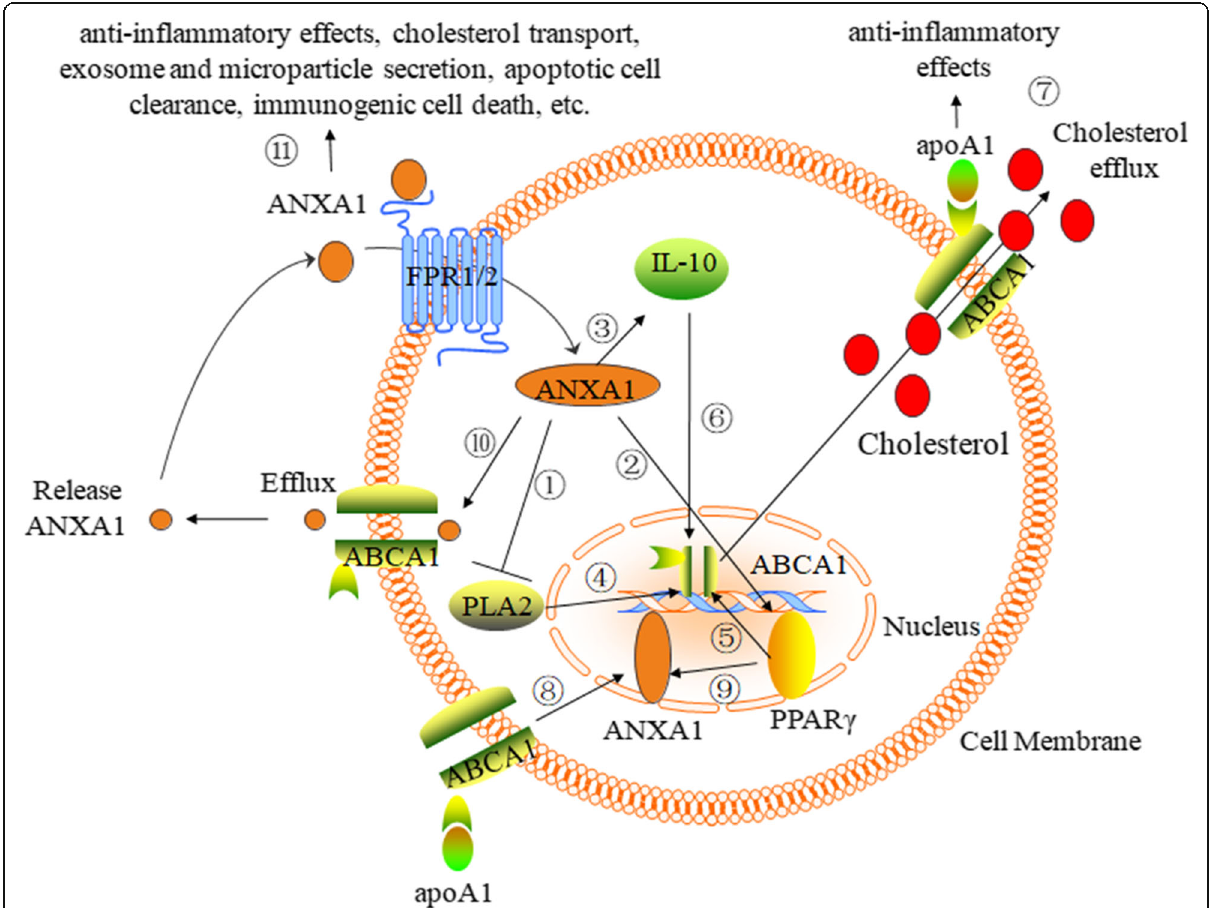
Fig. 1 The mechanism and function of the ABCA1 interaction with ANXA1. ANXA1 serves as an inhibitory protein of PLA2 ( ① ) and increases the expression of PPAR γ ( ② ), IL-10 ( ③ ). The expression of ABCA1 is increased by the PLA 2 inhibitory protein ( ④ ), PPAR γ ( ⑤ ), IL-10 ( ⑥ ). Therefore, ANXA1 increases ABCA1 expression and then combines with apoA-I to promote cholesterol efflux and anti-inflammatory effects ( ⑦ ). However, this function has not been investigated and requires further study. ABCA1 increases ANXA1 expression by binding to apoA-I, controlling the ERK, p38 MAPK, AKT, and PKC pathways ( ⑧ ), and PPAR γ increases ANXA1 expression by binding to the promoter of ANXA1 ( ⑨ ). ABCA1 transports ANXA1 and thereby mediates ANXA1 efflux and release ( ⑩ ), thereby promoting the functions of ANXA1, including anti-inflammatory effects, cholesterol transport, exosomes, microparticle secretion, apoptotic cell clearance, and immunogenic cell death ( ⑪ ). Thus, ABCA1, PPAR γ , and ANXA1 may form a feedback loop and regulate each other. However, this interaction among ABCA1, PPAR γ , and ANXA1 requires further